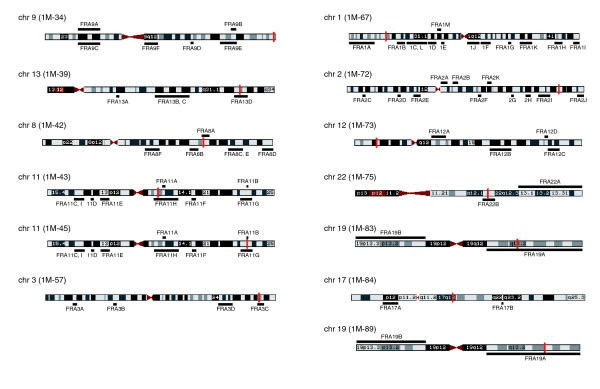
Positions of DHFR* integration sites and fragile sites. The DHFR* integration sites were mapped onto the genome using BLAT [46] and are shown as a red bar on the chromosome ideogram from the UCSC genome browser [45]. Common fragile sites are shown under the chromosome and are mapped according to positions reported in NCBI Entrez and the literature [65-77]. Rare folate sensitive fragile sites are shown above the chromosome. Note that the 1M-45DHFR* integration site mapped just proximal to FRA11B, another folate sensitive fragile site; however, no copy number transitions or amplicon boundaries mapped to this region. Since FRA11B is a RFS, it may not be expressed in HCT116.